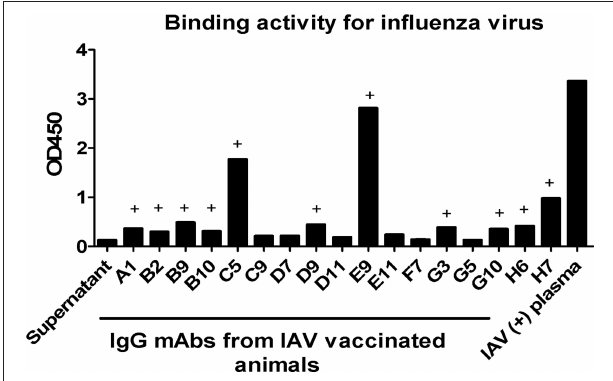
FIGURE 7 | Plasmablast-derived mAbs isolated from Chinese macaques display specific reactivity to influenza viruses. Single plasmablasts from Chinese rhesus macaques were sorted into a 96-well plate at day 4 after vaccination and were used to generate cDNA. Subsequently, the cDNAs were used as templates in nested PCRs with IgG heavy and light chain-specific primers. The paired IgG heavy and light chain sequences were cloned into antibody expression vectors and expressed in 293T cells after transfection. The mAbs produced were tested by ELISA. Inactivated influenza virus was coated onto a 96-well plate at a concentration of 1 µ g/ml. At 72h post transfection, 100 µ l IgG expression supernatant was used as the primary antibody. HRP-conjugated anti-human antibody was used as the detection antibody. Influenza A virus (IAV)-positive plasma was used as a positive control. The OD450 values of the blank control were subtracted from those of the other wells. ( + ) The minimum mAb concentration indicating antigen-specific binding was defined as an OD value ≥ 2-fold the OD value of the negative control.